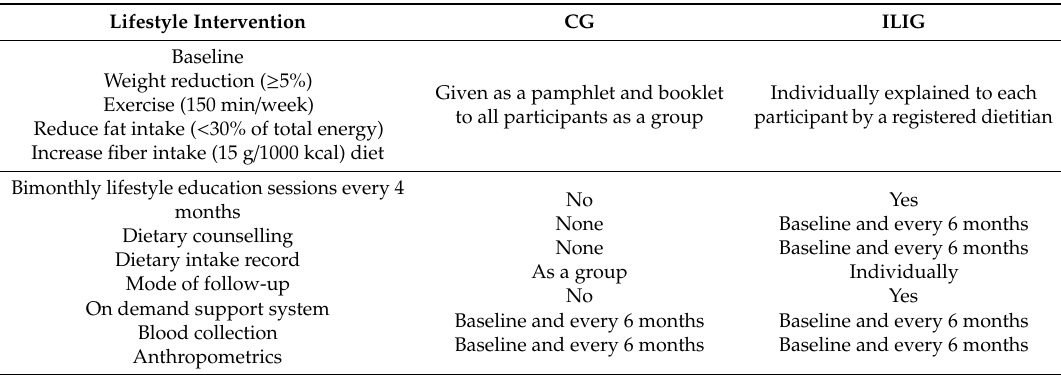
Table 1. Di ff erences between study group